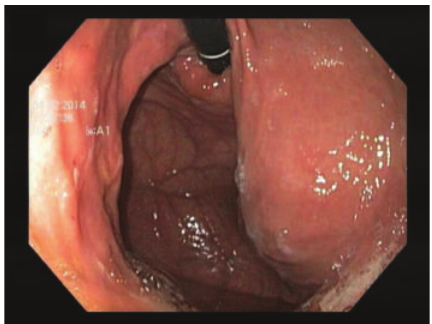
Figure 1: Bulge in the lesser curvature and posterior wall of the stomach.